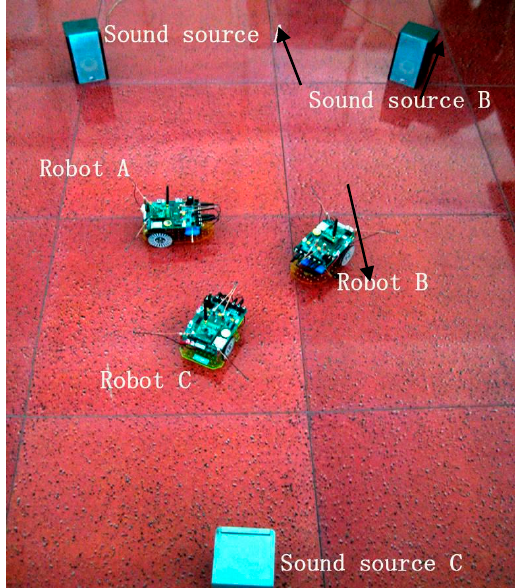
Figure 12. Experimental process.